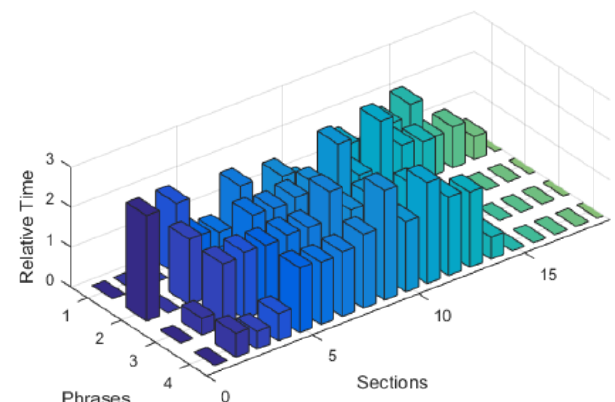
Figure 8. Relation of relative Google Speech-to-text service response times after sending the last frame of the audio speech data to